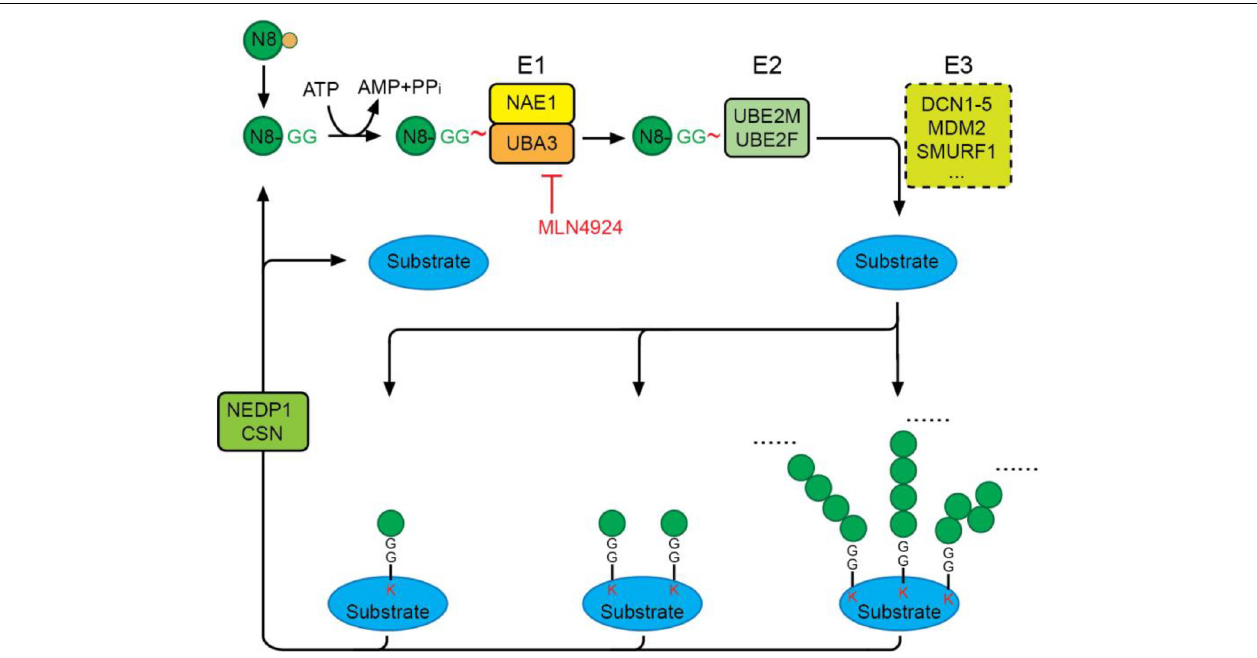
FIGURE 2 | The neddylation cascade. NEDD8 is first synthesized as a precursor that is proteolytically processed to expose its C-terminal glycine. The matured NEDD8 is then activated by forming a thioester linkage with NAE—a heterodimer of UBA3 and NAE1—in an ATP-dependent manner. Activated NEDD8 is then transferred from the active cysteine site of NAE to the active cysteine site of E2 UBE2M or UBE2F. Interaction of E2 with an E3 ligase positions the C-terminal glycine for nucleophilic attack by the lysine residue on the substrate, resulting in covalent linkage of NEDD8 to target proteins via an isopeptide bond. Protein substrates can be modified by mono-, multi-mono, or a chain of NEDD8 via different linkages. The deneddylases, NEDP1 and CSN, catalyze the removal of NEDD8 moieties from substrates. MLN4924 is a specific neddylation inhibitor that acts by preventing NAE-mediated NEDD8